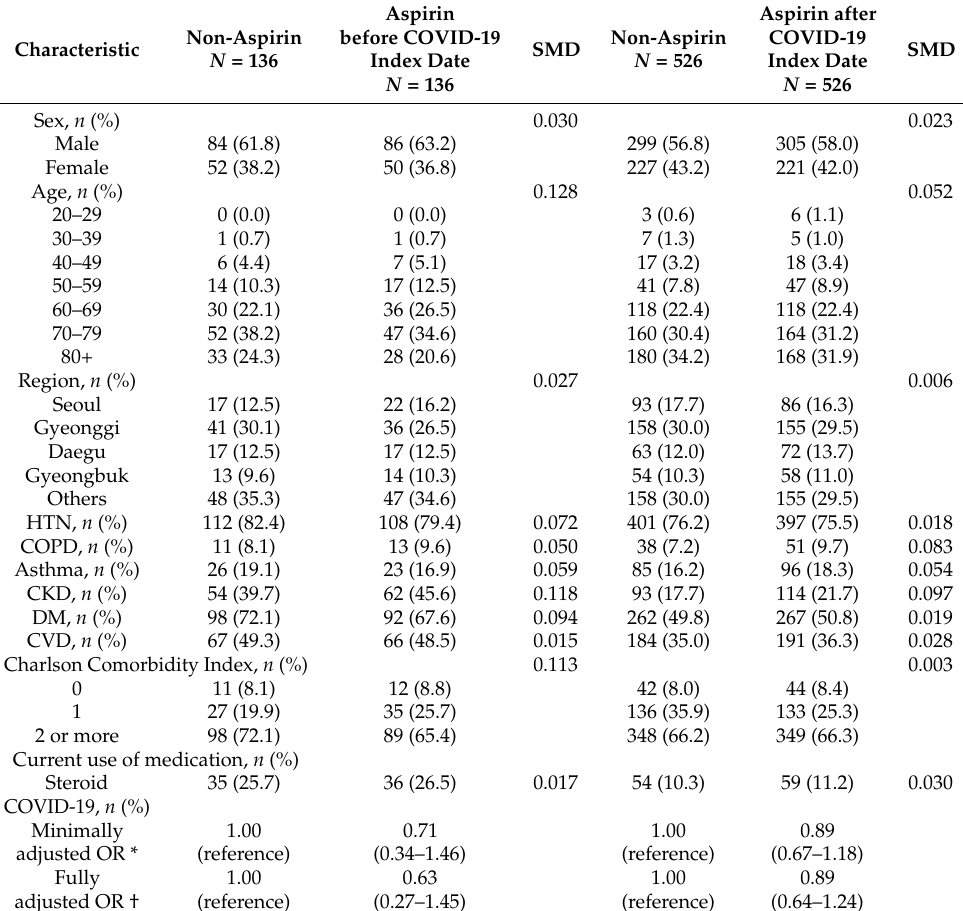
Table 2. Propensity score-matched baseline characteristics and COVID-19 test positivity between non-aspirin and aspirin